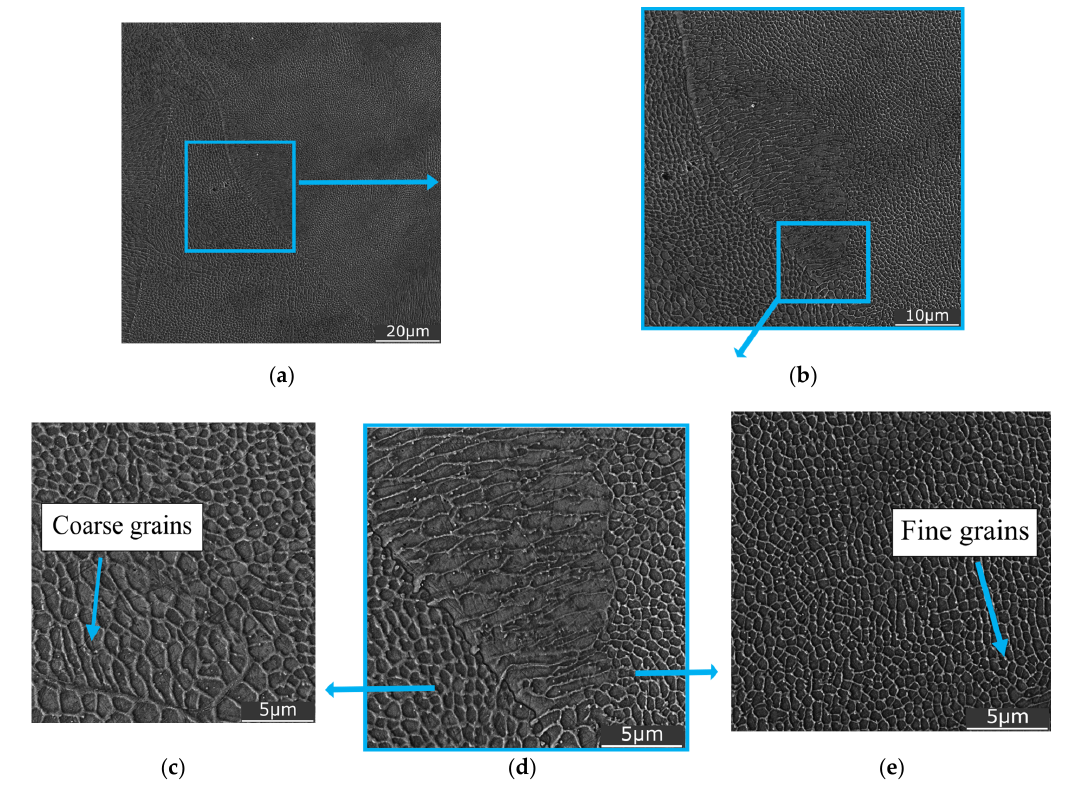
Figure 9. Detailed view of the microstructure of sample 1 (XY plane), ( a , b , d ) area of interest, ( c ) detail of coarse grains, ( e ) detail of fine